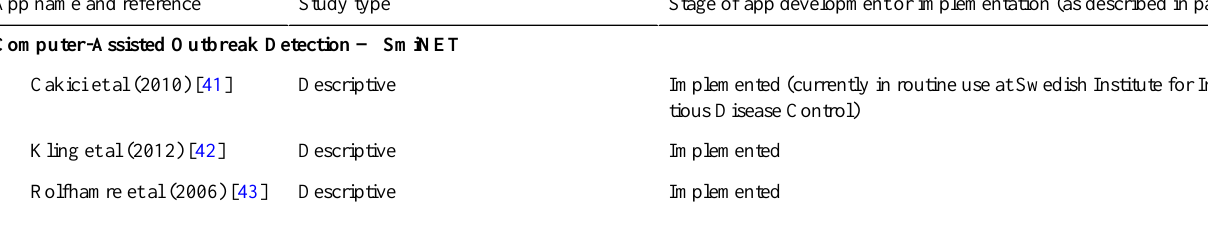
Stage of app development or implementation (as described in paper)Study typeApp name and reference Implemented (currently in routine use at Swedish Institute for